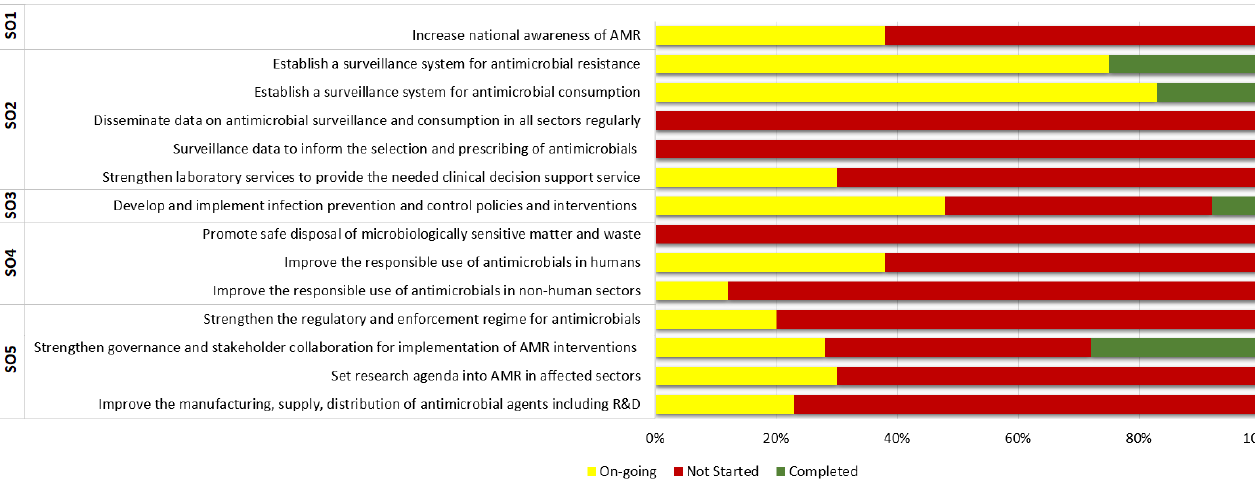
Figure 3 . Level of implementation of Ghana NAP on AMR, Mid-term review 2020. Own design, based on [51] .